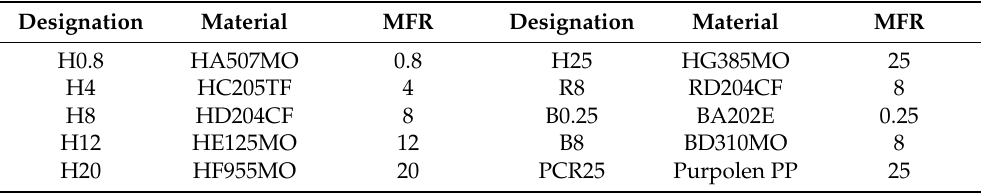
Table 2. List of used material grades with their corresponding designation; MFR values are given in g/10